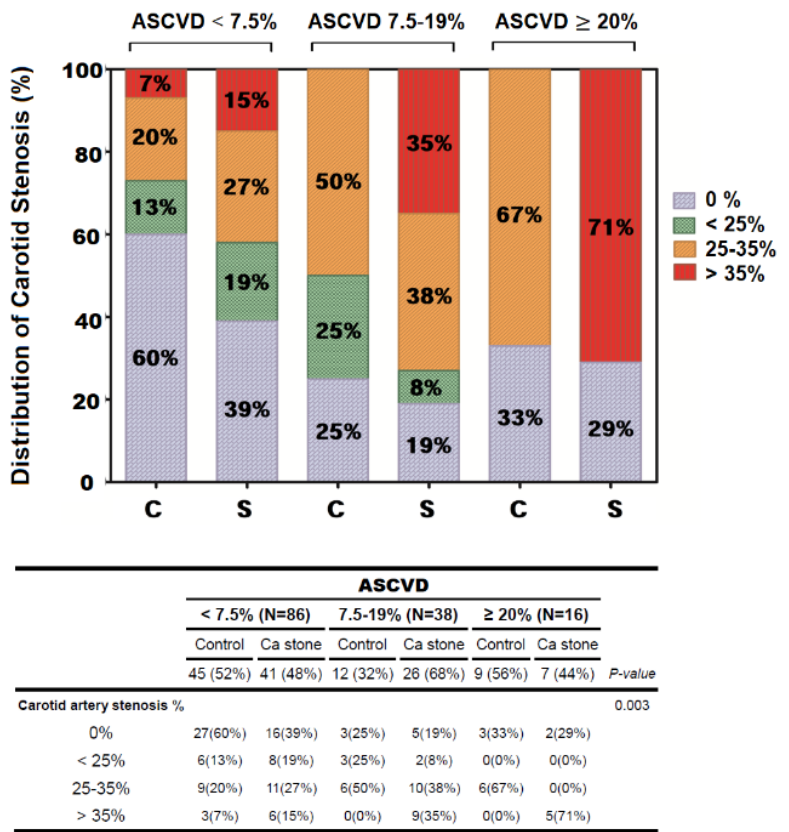
Figure 2. A bar chart for comparing distribution of carotid artery stenosis (%) between the control and kidney stone groups according to three different ASCVD risk scores. FRS: Framingham risk score, C: control, S: kidney stone.